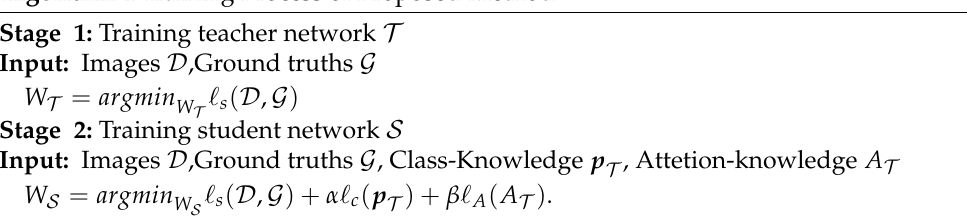
Algorithm 1 Training Process of Proposed